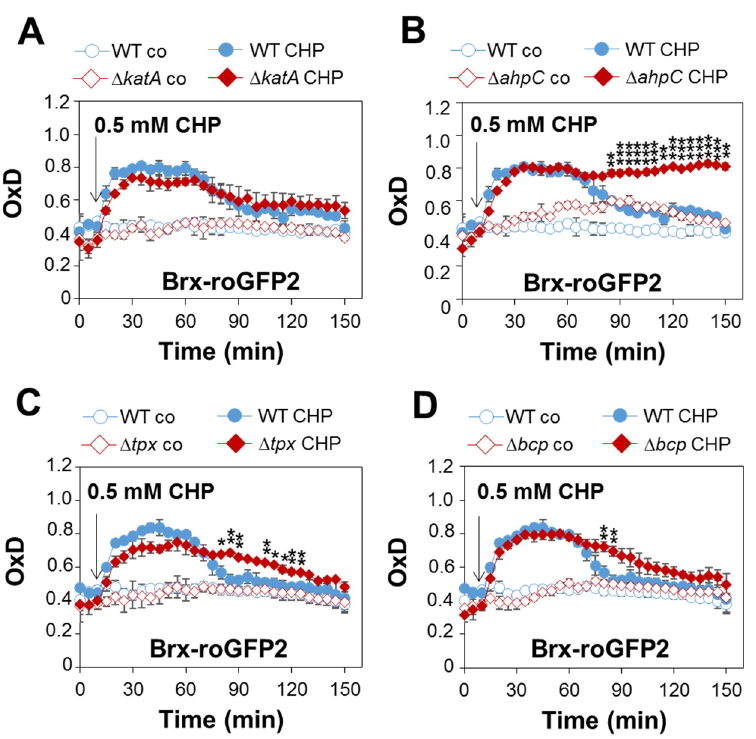
Figure 7. AhpC, Tpx and Bcp function in CHP detoxification and regeneration of reduced E BSH during the recovery phase, as revealed by the Brx-roGFP2 biosensor. ( A – D ) Brx-roGFP2 responses to 0.5 mM CHP in S. aureus COL WT, ∆ katA ( A ), ∆ ahpC ( B ), ∆ tpx ( C ) and ∆ bcp mutants expressing Brx-roGFP2 from plasmid pRB473. H 2 O 2 injection assays were performed in microplates and the biosensor responses measured using the CLARIOstar microplate reader, as described previously [45]. ( D ) The oxidation degree (OxD) of the Brx-roGFP2 response was calculated based on the 405/488 nm excitation ratio and normalized to fully reduced (DTT-treated) and oxidized (diamide-treated) controls. Mean values and SD of three biological replicates are shown. The statistics were calculated using Student’s unpaired two-tailed t-test in Graph Prism. Symbols: ns p > 0.05, * p ≤ 0.05, ** p ≤ 0.01 and *** p ≤ 0.001.